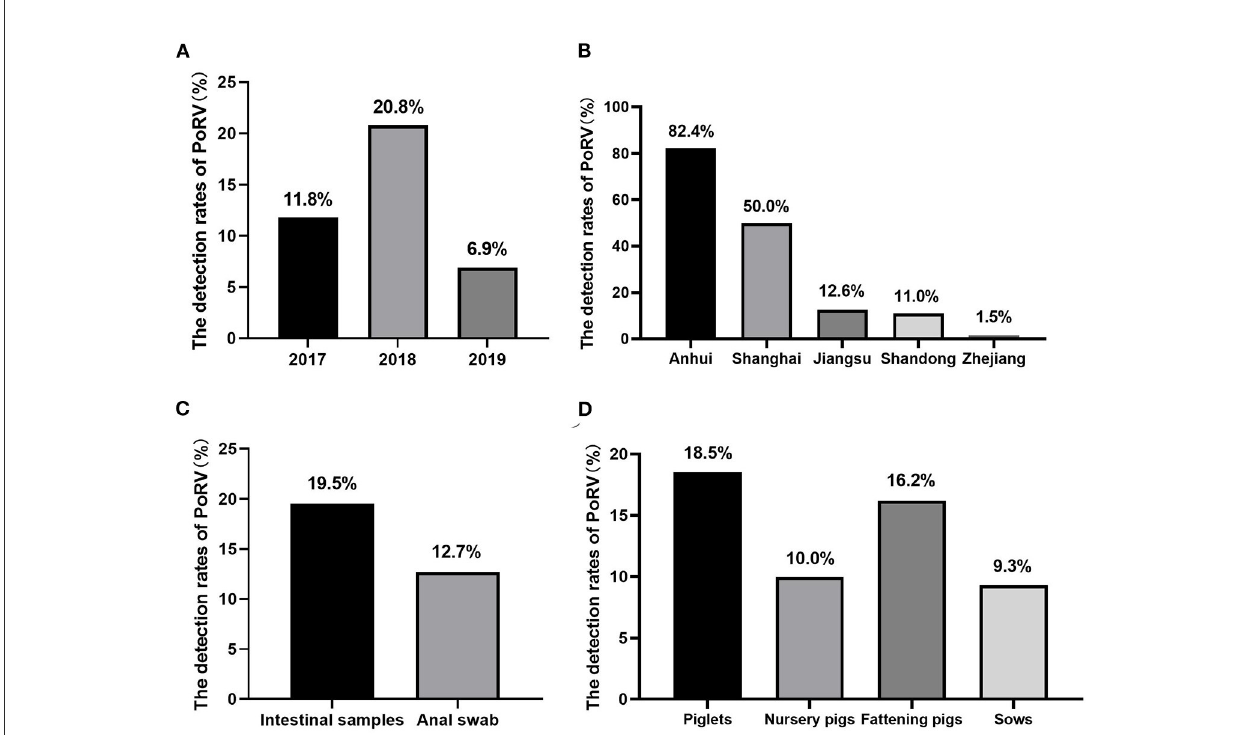
FIGURE1 The prevalence of RVA in East China: (A) the positive rates of RVA of each year during this study. (B) The prevalence of RVA in different provinces/cities in East China. (C) The positive rates of different kinds of collected samples. (D) The detection rates of RVA in pigs at different growing